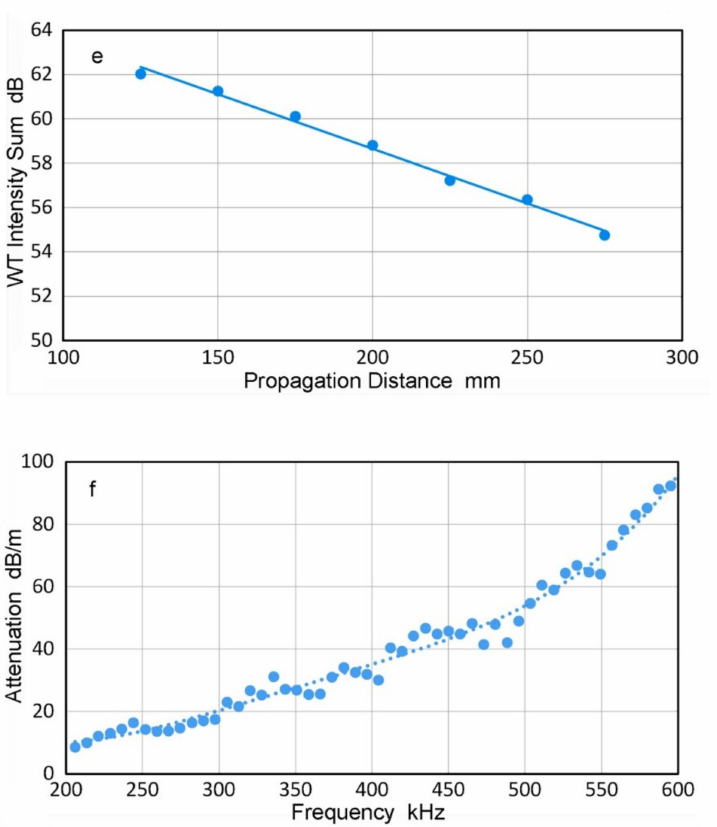
Figure 3. ( a ) Displacement amplitude (in pm) of symmetric Lamb waves detected on front side (blue curve), back side (green curve) and summed (halved, red curve) on 1.4-mm PS sheet. Propagation distance: 200 mm. Signal arrival: 97 µ s, Transmitter (Tx): NDT C16 (normal incidence), Receiver (Rx): KRN-BB-PC. ( b ) Displacement amplitude (in pm) of asymmetric Lamb waves. Same sample and transducers as above except halved signal difference is shown as red curve, Tx incident angle of 60 ◦ used and signal arrival at 169 µ s (plotted from 170 µ s). ( c ) Wavelet transform spectrogram of the summed signal (red curve, ( a )). Transform start time was shifted by 97 µ s. Red and blue represent high and low WT intensities. Dispersion curves for S o and A o modes are also plotted. Insert shows a partial WT spectrogram at propagation distance of 125 mm, shifted by 60 µ s. ( d ) Wavelet transform spectrogram of the difference signal (red curve, ( b )). Transform start time was shifted by 169 µ s. Dispersion curves for S o , A o and A 1 modes plotted. ( e ) WT intensity sum, D propagation distance, x, for symmetric Lamb waves on 1.4-mm PS sheet. The slope from the linear regression fit gives S o -mode attenuation coefficient, α –S o at 496 kHz. ( f ) α –S o values vs.